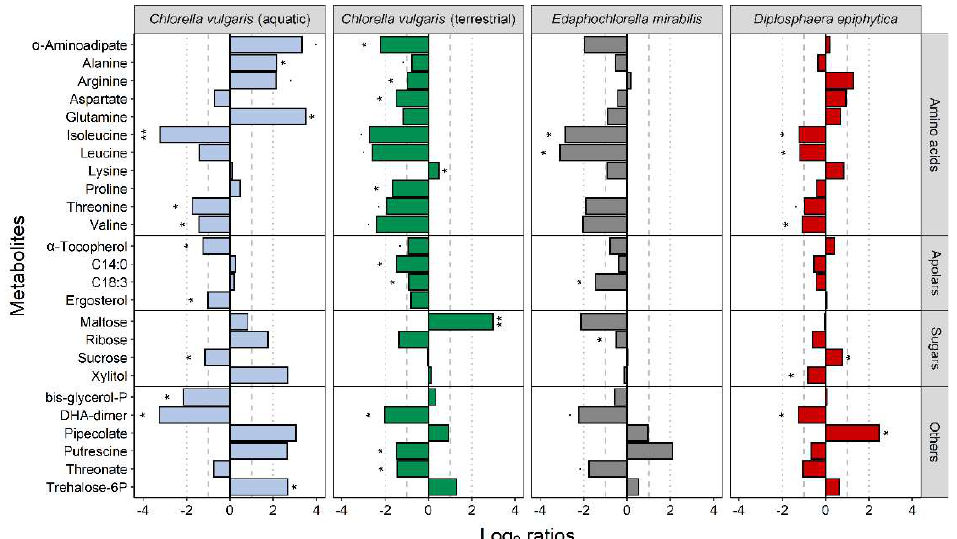
Figure 7. Effects of desiccation and rehydration on the metabolite profiles of the four algal strains. Blue, green, grey, and red colours indicate the aquatic and the terrestrial Chlorella vulgaris strains, Edaphochlorella mirabilis and Diplosphaera epiphytica, respectively. Previously published datasets for the two C. vulgaris strains [4] were used for meta-analysis. The effects of the desiccation-rehydration treatment on metabolite accumulation are shown as log 2 ratios (metabolite contents after the desiccation-rehydration treatment divided by the metabolite contents in nondesiccated controls). A positive log 2 ratio indicates that a given metabolite was up-accumulated after the treatment and a negative log 2 ratio indicates that it was down-accumulated. Differences are shown for all metabolites differentially accumulated after the treatment as compared to the control (FDR-corrected Welch t -test at p < 0.05; log 2 ratios >1) in at least one of the strains, with one and two asterisks denoting adjusted p -values below 0.05 and 0.01, respectively, for the given comparison.